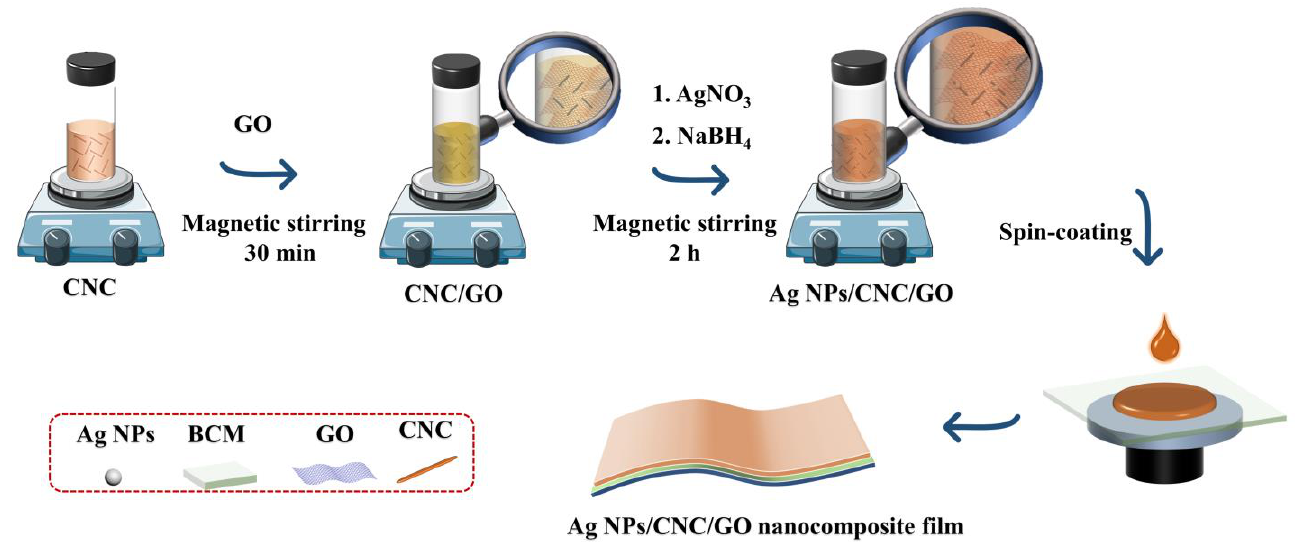
Figure 1. Diagram of the preparation process of Ag NPs/CNC/GO nanocomposite films using self- assembly.